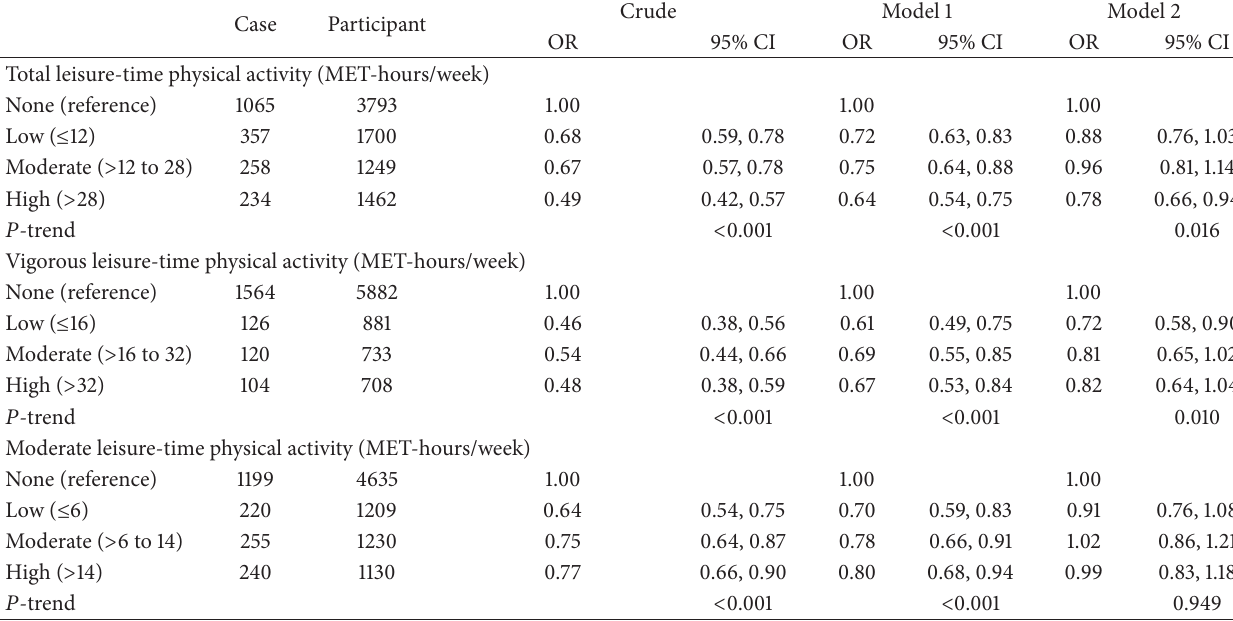
Table 2: Odds ratios of prediabetes according to category of leisure-time physical activity, NHANES 2007–2012, ages 20–65 y. Case